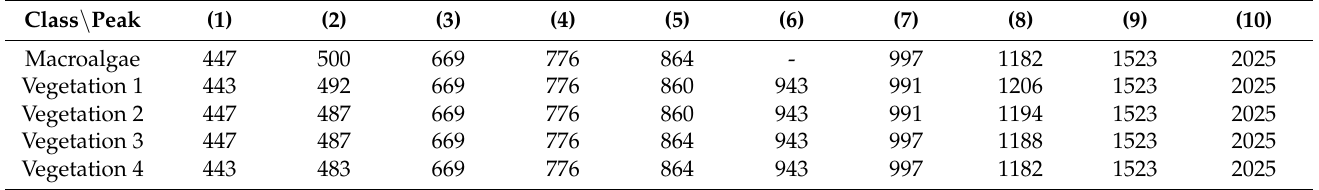
Table 1. Wavelengths of the absorption peaks detected in the spectral signature of the marsh vegeta- tion classes of Cadiz Bay. The numbers in the column headers correspond to the peaks indicated in Figure 5. Units: